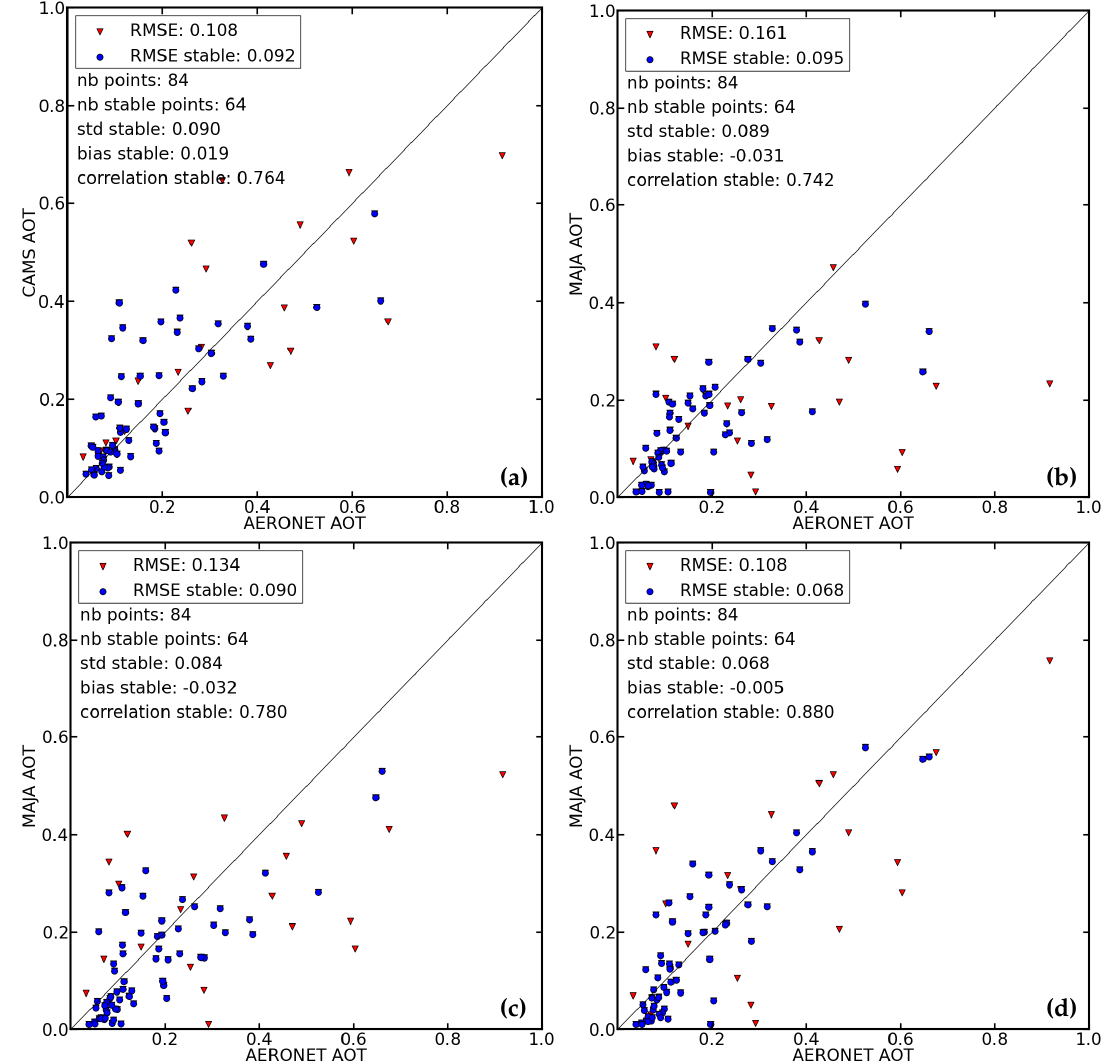
Figure 3. Scatter plots of aerosol optical thickness (AOT) at 550 nm versus AERONET (Aerosol Robotic Network) observations over arid sites: ( a ) AOT predicted by CAMS (Copernicus Atmosphere Monitoring Service); ( b ) AOT estimated by the MACCS-ATCOR Joint Algorithm (MAJA) with a constant aerosol type; ( c ) AOT estimated by MAJA using four CAMS aerosol types; and ( d ) AOT estimated by MAJA using five CAMS aerosol types. RMSE: root-mean-square error. std: standard